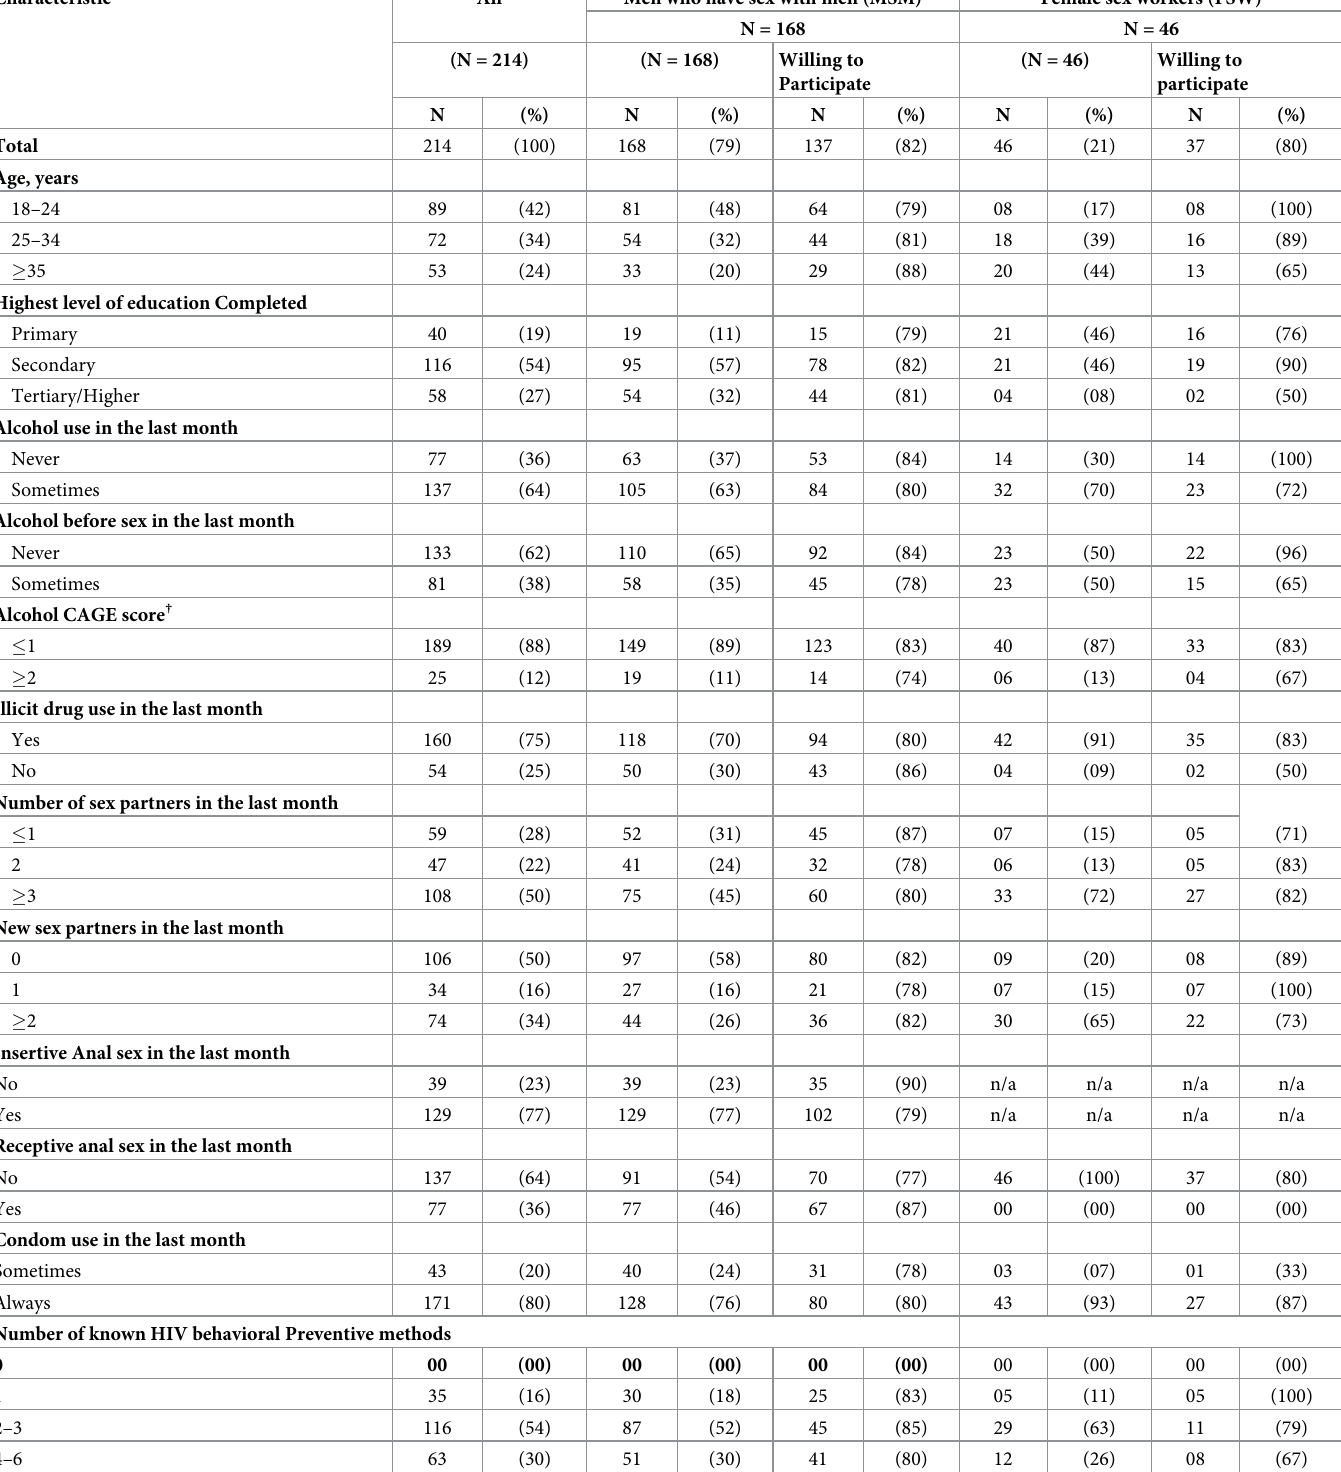
Table 1. Characteristics of 214 participants enrolled in a simulated HIV vaccine trial in Nairobi and the proportion willing to enroll in a future HIV vaccine trial, Nairobi, Kenya; Sep 2015-Sep 2018.